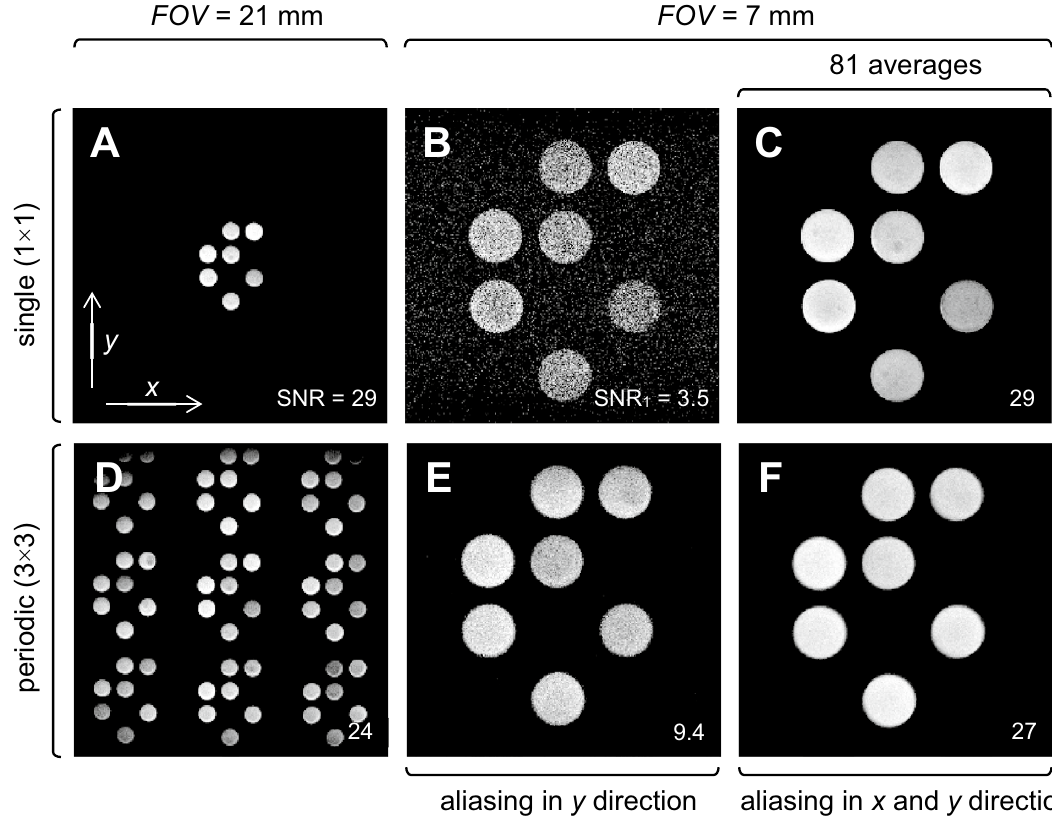
Figure 2. MR images of the test sample. ( A-C ) Images when only the central object was oil-filled and ( D-F ) images when all objects were oil-filled. ( A , D ) When the sample was scanned at FOV of 21 mm, SNR was 9 times higher than ( B ) that scanned at FOV of 7 mm (the voxel is reduced by a factor 9), and there was no signal amplification due to aliasing. ( E ) With signal aliasing only in the phase-encoding direction, the SNR increased by a factor of 3 and ( F ) when signal aliasing was present along both symmetry axes, SNR increased by a factor of 9 so that it reached the level of SNR before the FOV reduction. ( C ) Image resulting from 81 averages with standard scanning of the object at small FOV . The resulting image features about the same SNR as ( F ) the constructive aliasing approach with small FOV and no